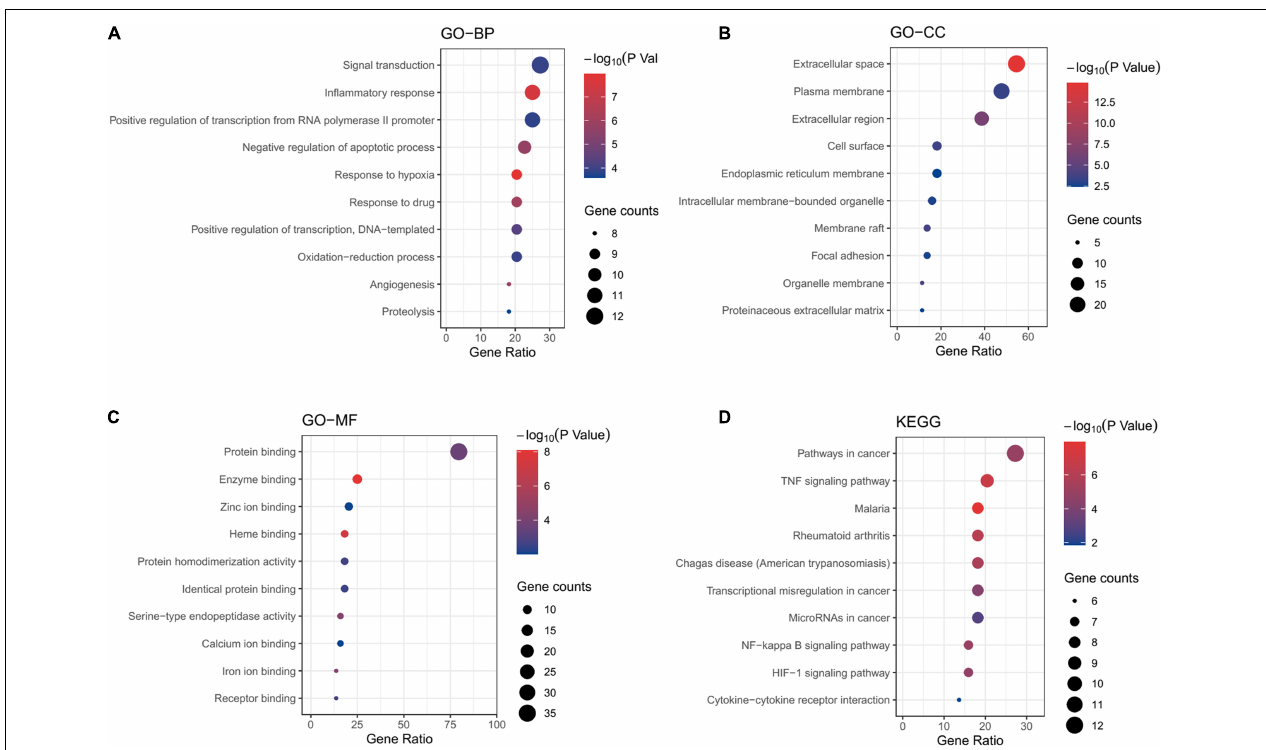
FIGURE 5 | Enrichment analyses of potential targets. GO enrichment analysis. The top 10 terms of each part are shown: (A) GO-BP, biological processes, (B) GO-CC, cell component, (C) GO-MF, molecular function. (D) KEGG pathway analysis.